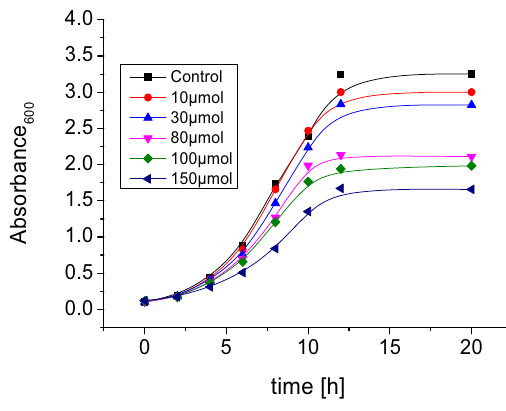
Figure 8: Growth curves of S. cerevisiae during a 24 h cultivation in the presence of 10; 30; 80; 100; and 150 μ M of complex 3 .